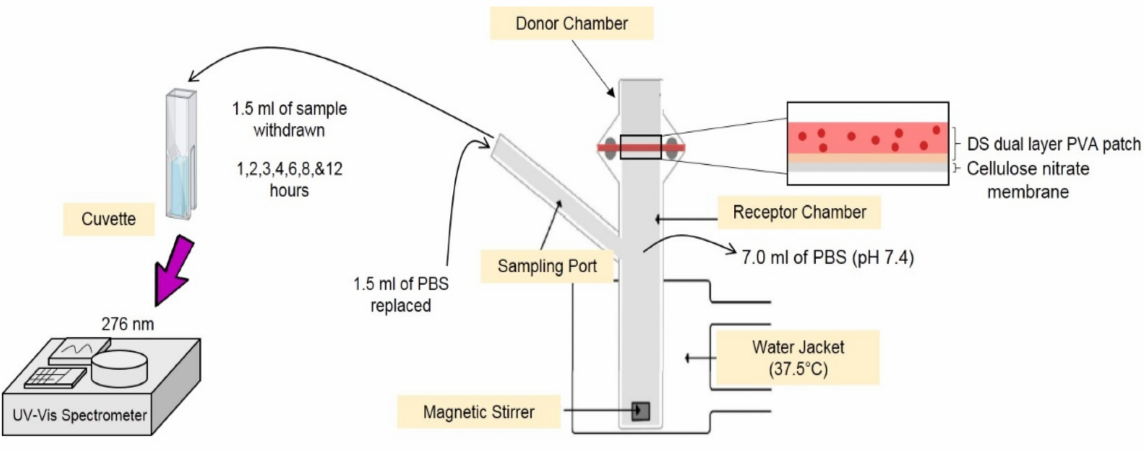
Figure 1. Franz diffusion cell set up for diffusion